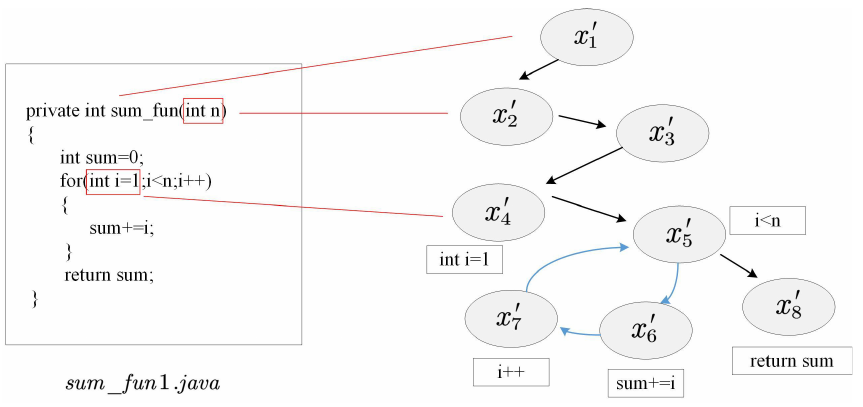
Figure 5. The CFG of source code sum _ fun 1. java